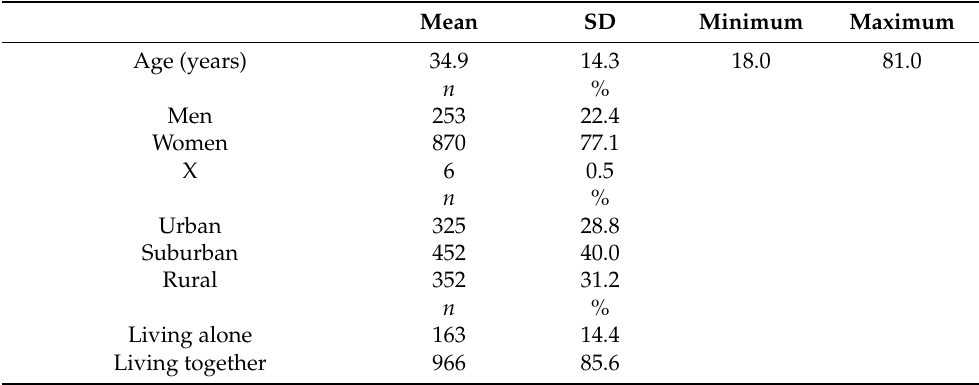
Table 2. Descriptive data of the